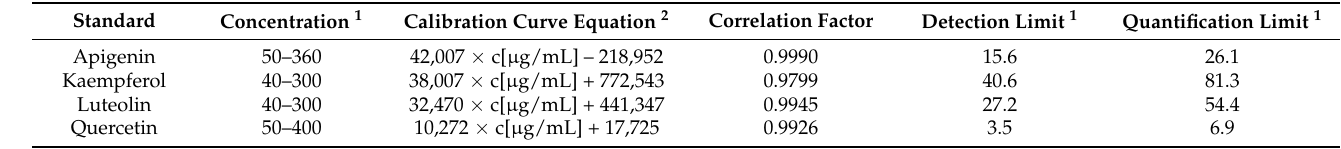
Table 3. Calibration curves